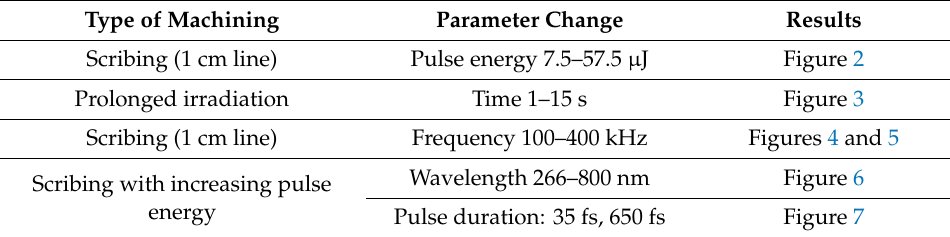
Figure 3. Aluminum sample irradiated with sub-picosecond Yb:KYW laser (57.5 µJ, 650 fs, 1030 nm, 200 kHz). Table 3. The summary of the experiment